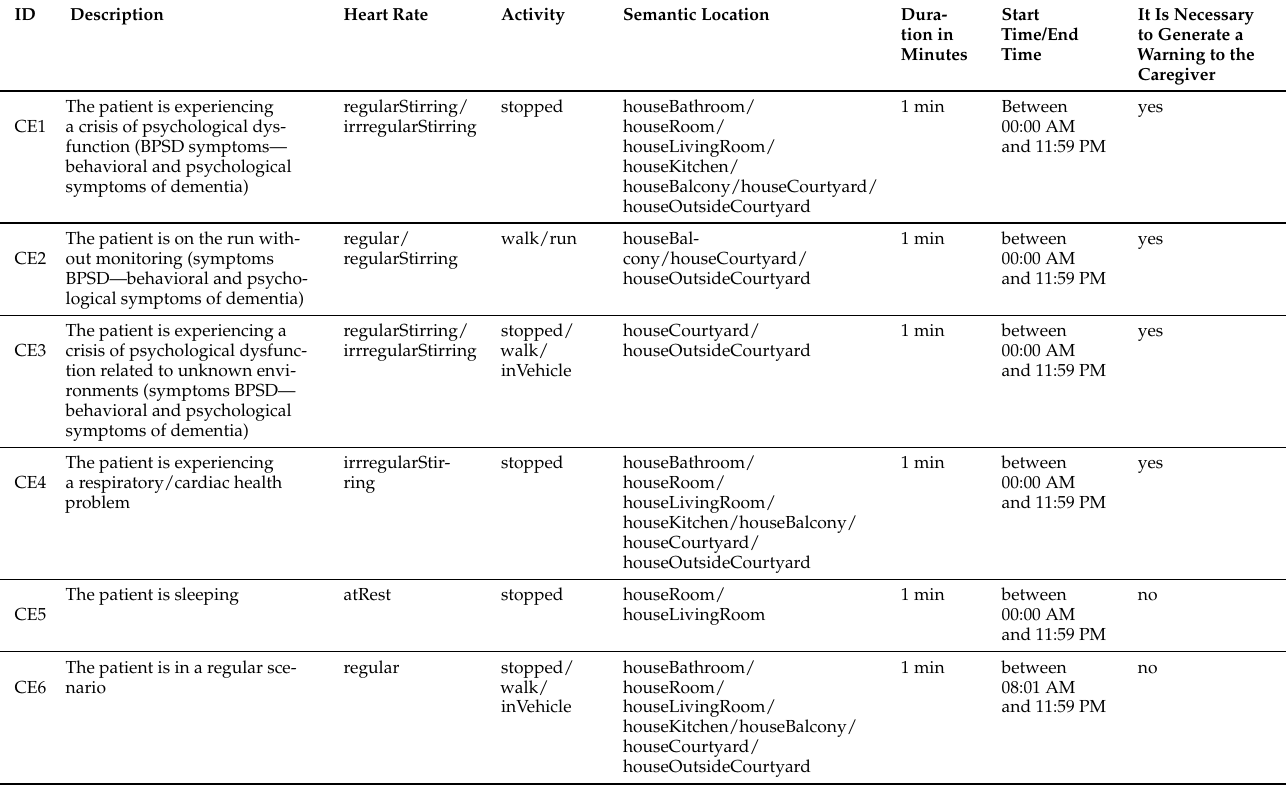
Table 1. Scenarios developed based on the literature.